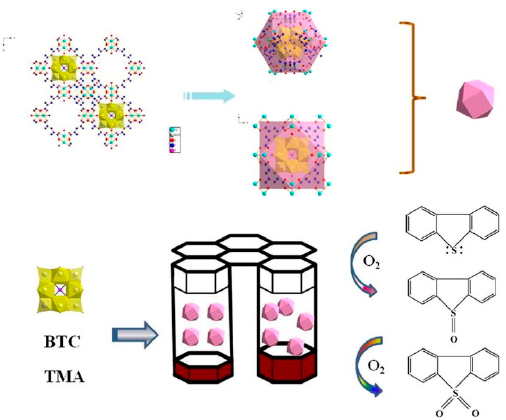
Figure 44. Schematic representation of POM@MOF-199@MCM-41 hybrid system